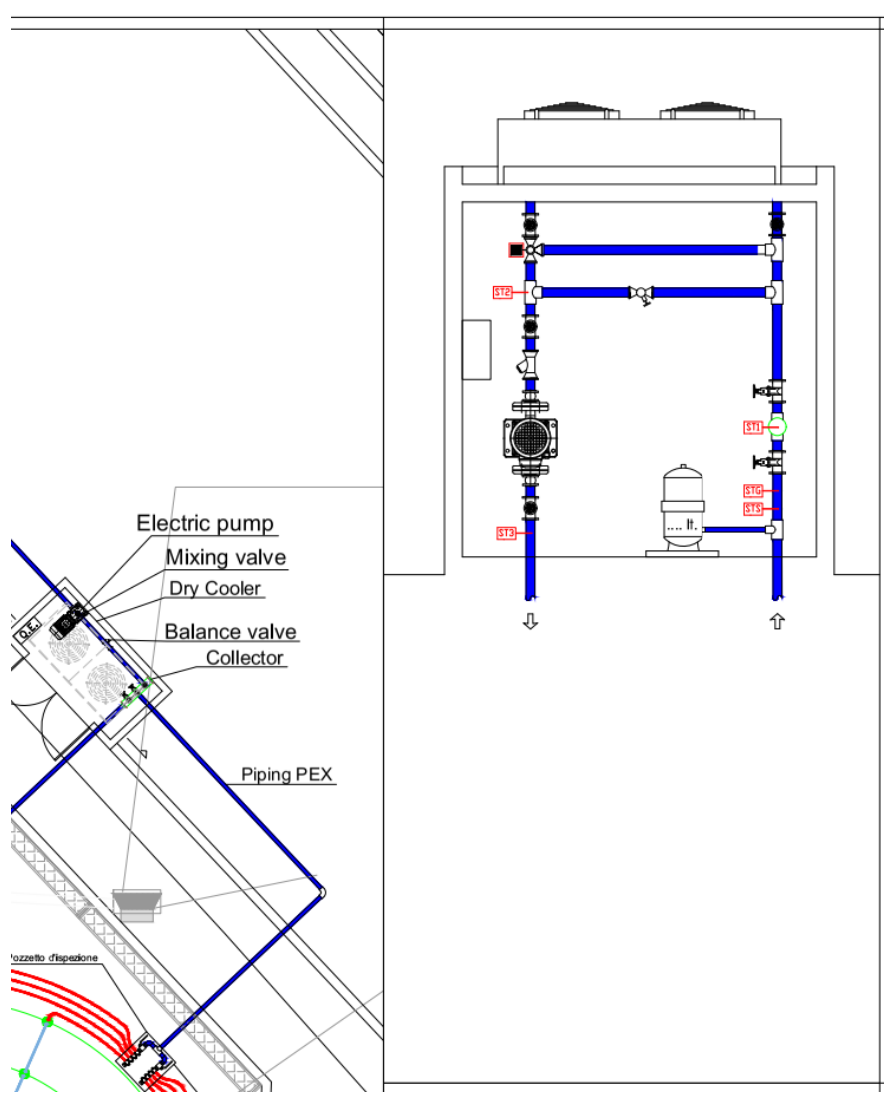
Figure 8. A detail of RTC + BTES of the experimental set-up.